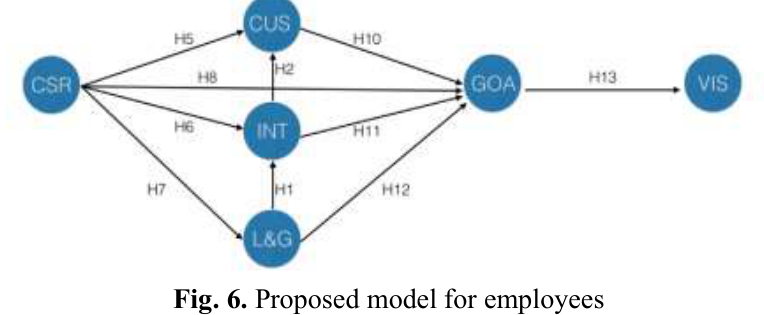
Fig. 6. Proposed model for